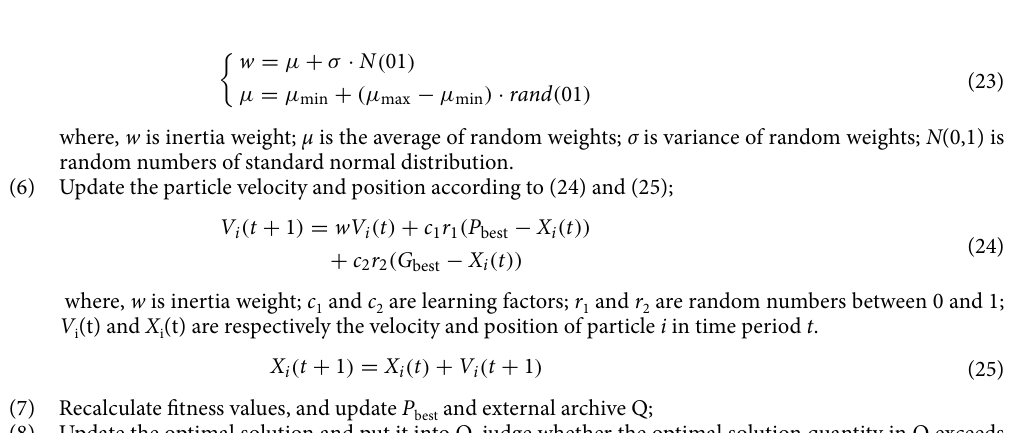
Table 3. Related information of household